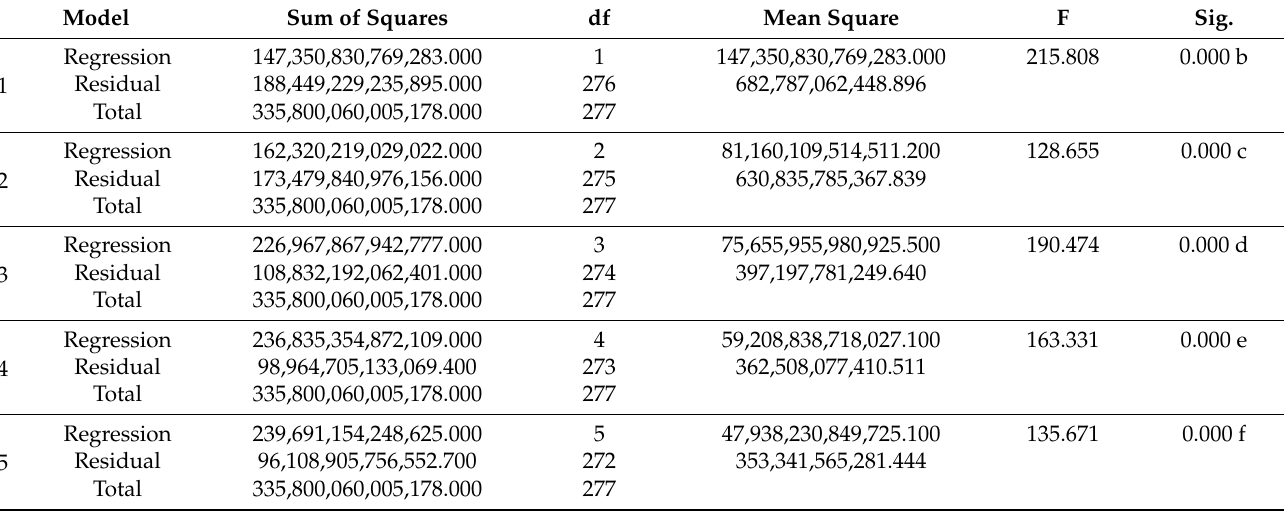
Table 5. ANOVA test